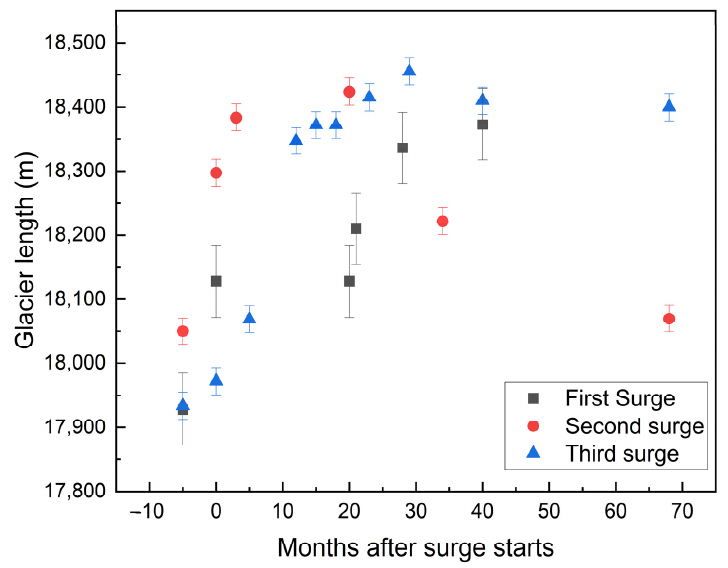
Figure 5. The change in the length of the glacier over a period of time after the beginning of the surge. A negative abscissa means before the surge. The error bar represents uncertainty in the length of the glacier.